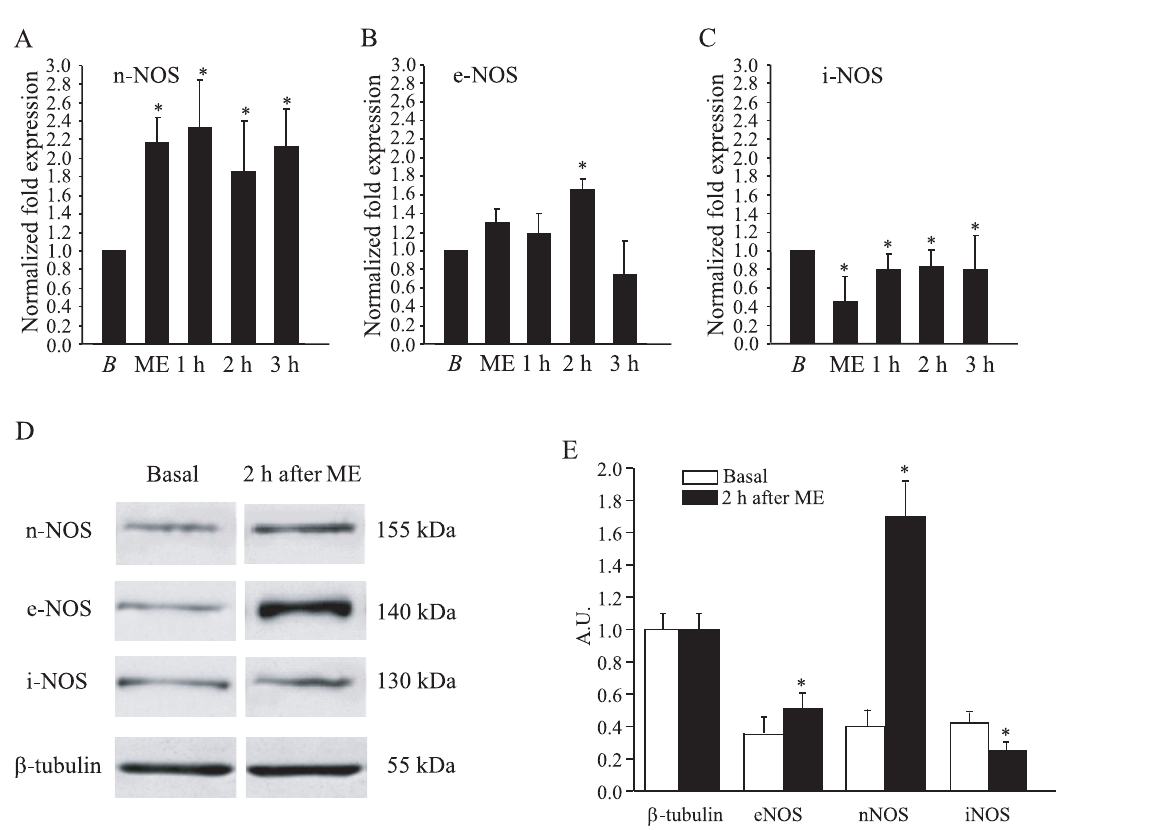
Fig. 6. The expression of nNOS and e NOS was increased 2 hours after 10 minutes ME. (A) The gene coding for nNOS was significantly more expressed at all the times considered with respect to the baseline value (B). The expression of the gene coding for eNOS was significantly more expressed at 2 hours after ME with respect to all the other time points considered (C). The gene coding for iNOS was significantly less expressed at all times after ME with respect to the baseline value. (D) Western blotting performed with brain samples from rats sacrificed 2 hours after ME shows that, at this time, the blot for nNOS and e NOS was more positive compared to the ones obtained in baseline conditions (upper blots), whereas both the iNOS expression and the b - tubulin expression (lower blots) were comparable at the two times considered. (E) Histograms showing the ratio of the optical density between b -tubulin and eNOS, nNOS and iNOS calculated for the baseline condition and 2 hours after ME. * Significantly different from the baseline value. Abbreviations: A.U. arbitrary